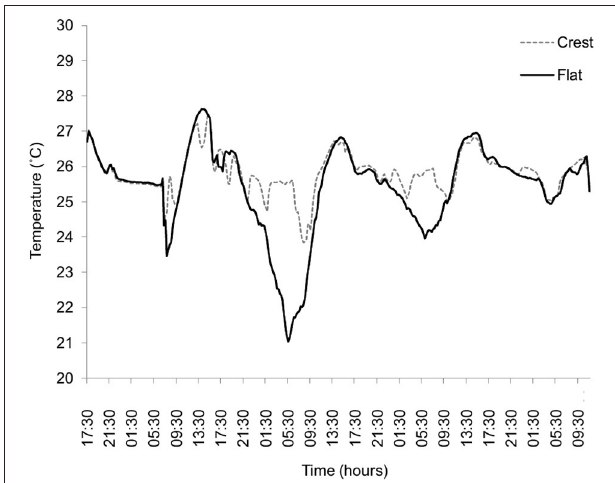
FIGURE 2 | Temperature ( ◦ C) measurements taken from the reef flat (black line) and reef crest (gray line, dashed) located on Suleman Reef, South Sinai, Egypt. Temperature was taken every 4 h over a 4 day period (Nov) at ∼ 1m depth.